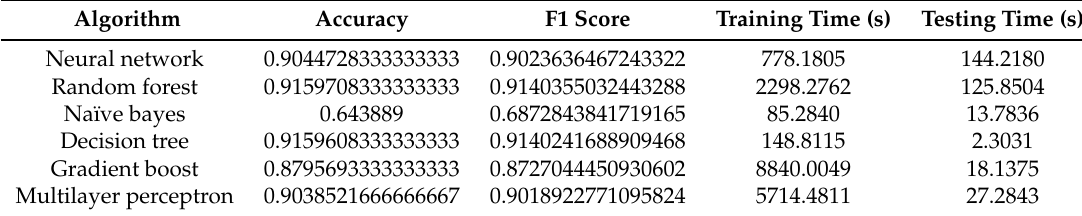
Table 12. Obtained results from the MQTT dataset with balanced dataset.